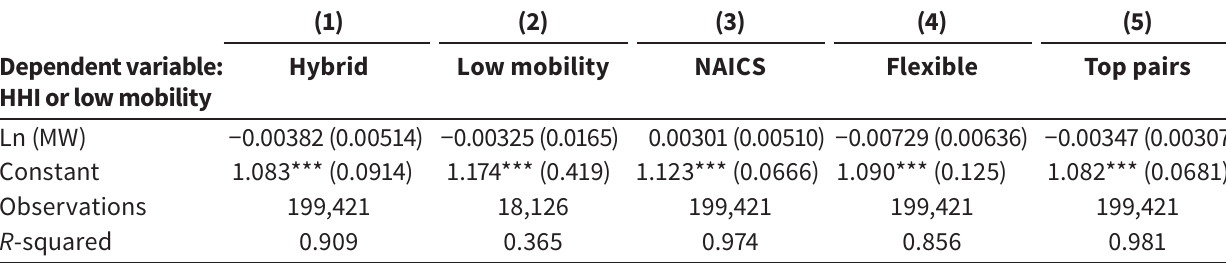
Effects of the log of the minimum wage on HHI and low mobility